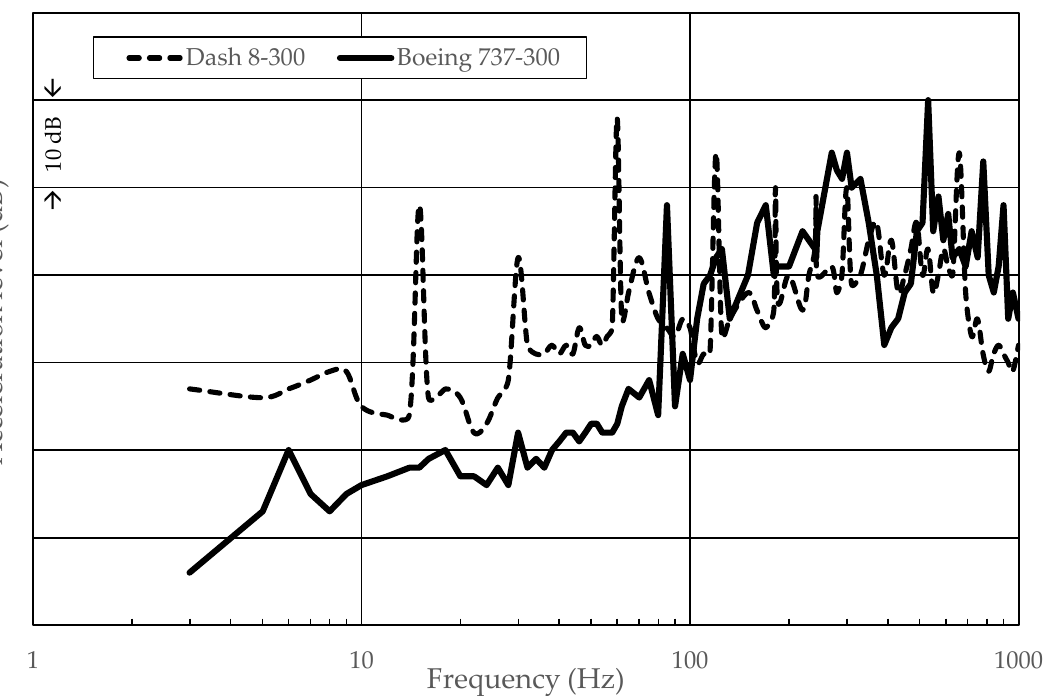
Figure 1. Typical vibration measured at the seat rail in the vertical direction for a turboprop (Dash 8) and jet aircraft (737) during the cruise phase (adapted from [25]). NB absolute values are not reported in the source.